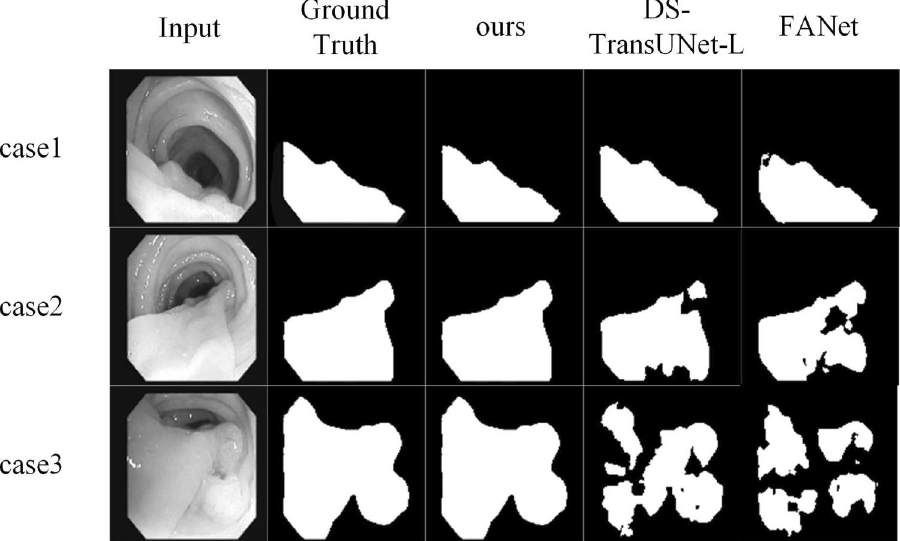
Figure 5. lists the qualitative results of TGMLP U-Net in Polyp Segmentation tasks versus results of other models. Our model with better learning and generalization abilities has better